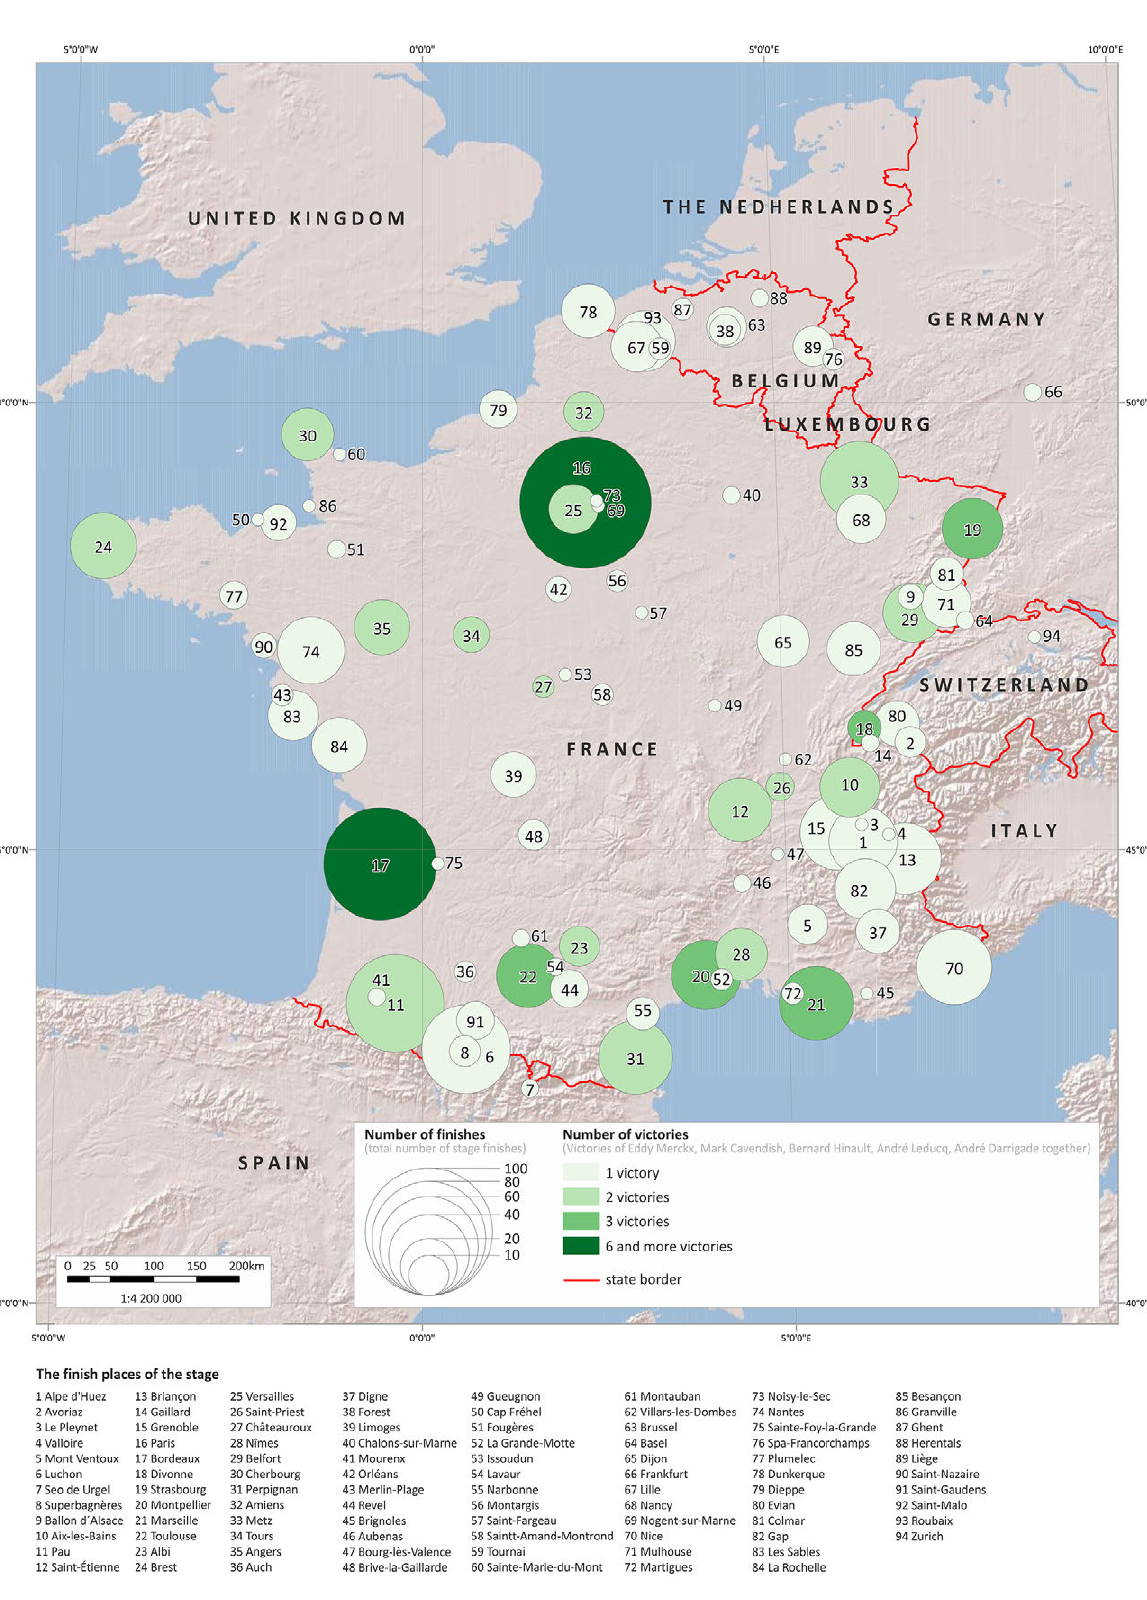
Fig. 8. Places of stage triumphs of the five most successful cyclists in the history of Tour de France according to the number of stage